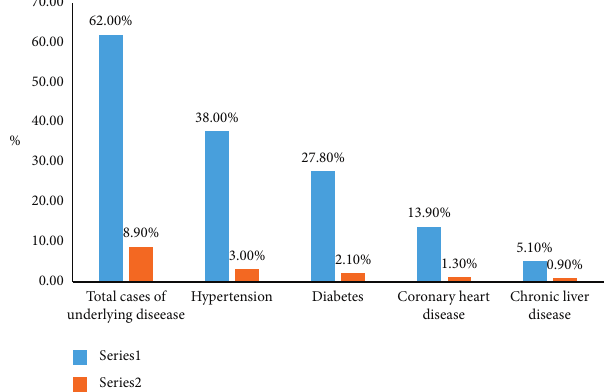
Figure 3: Underlying diseases in confirmed COVID-19 patients of different severities (62% of the severe and critical cases had un- derlying diseases, compared to 8.9% of the mild and common